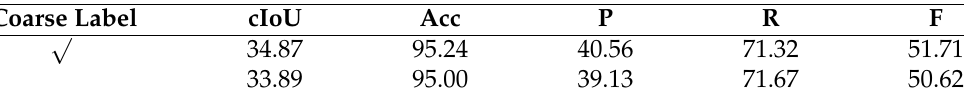
Table 7. Ablation study for skip connection (RES101). ing features to generate the final Predictions.